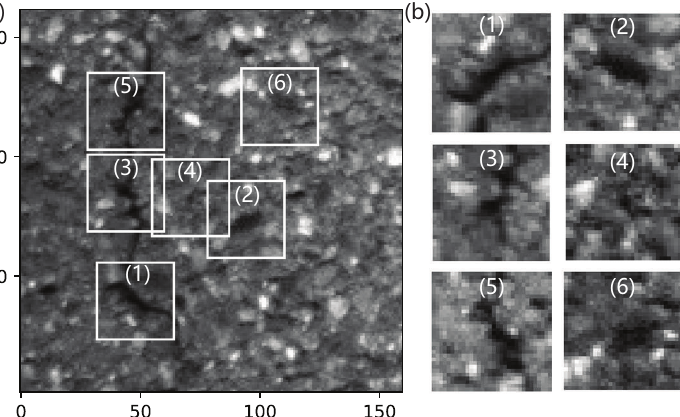
Figure 3. ( a ) The detected image blocks in the image window. ( b ) Most image blocks belong to the identical